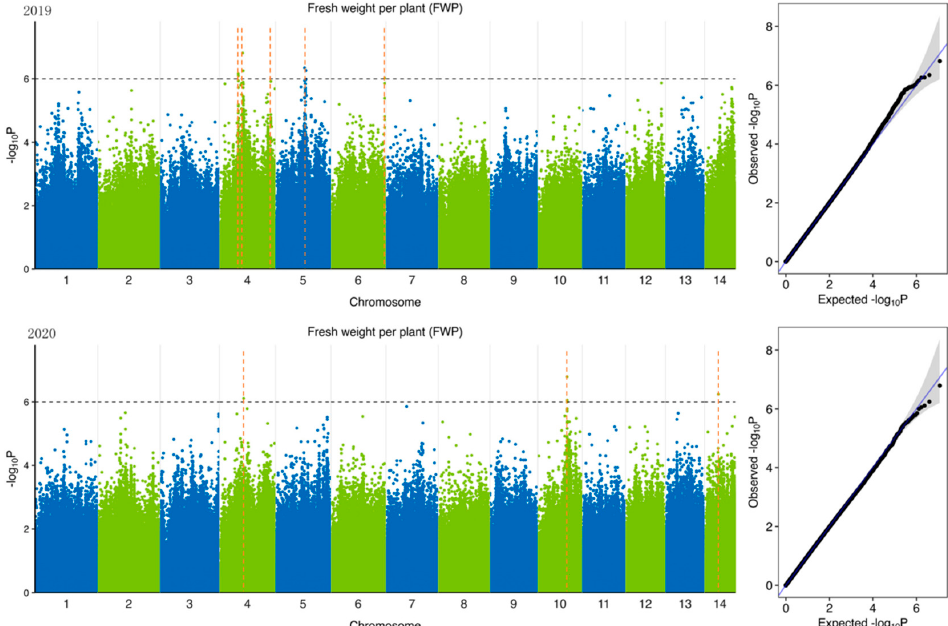
Figure 3. Manhattan plots of GWAS results for dry weight per plant (DWP) in 2019 and 2020. Notes: Blue and green dots represented SNP (single nucleotide polymorphism) sites on chromo- somes, respectively. When the value of − log 10 p was above 6 (gray line), the selected SNP site with significant aboriginality. Orange dotted lines represented the location of SNP loci.